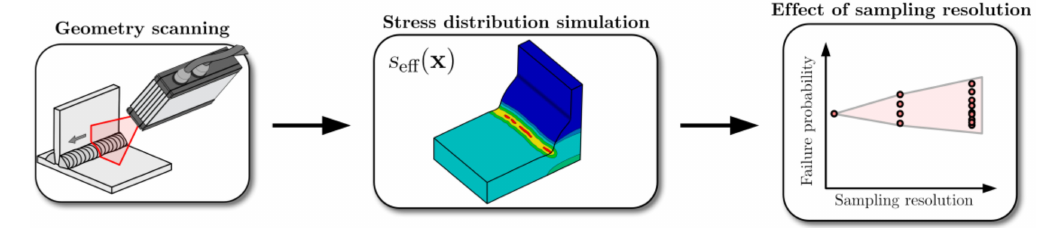
Figure 1. Workflow of the present